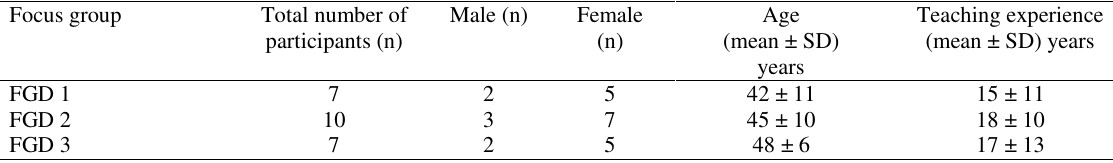
Note: SD = Standard deviation